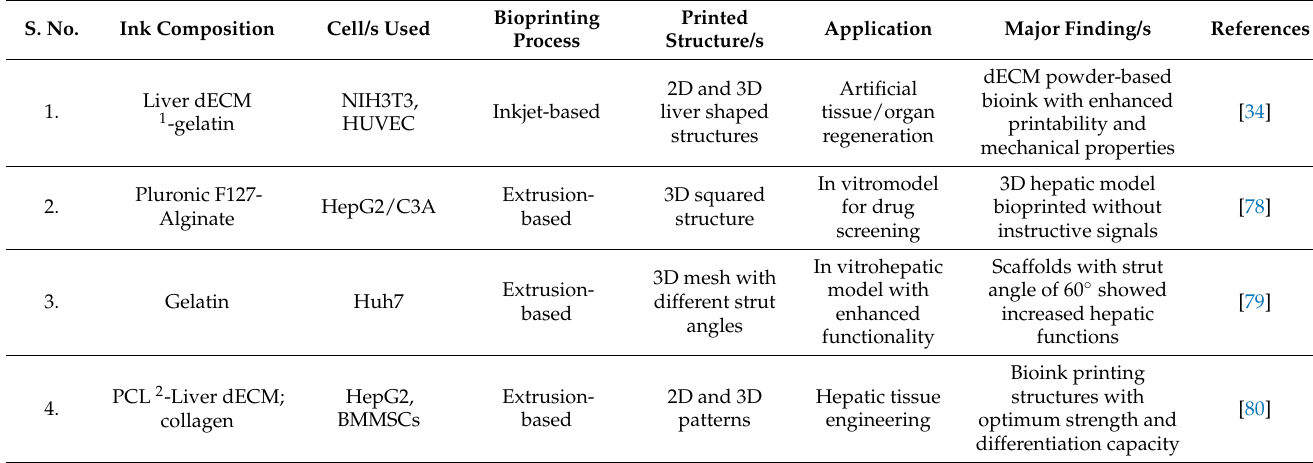
Table 2. Summary of major studies on 3D hepatic bioprinting in the last 5